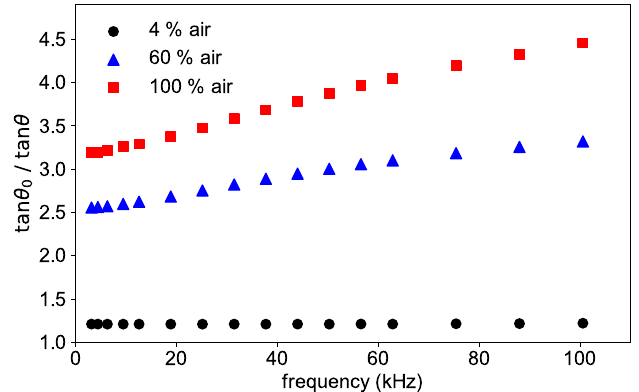
Figure 4. Phase shift measured at three different oxygen concentrations at the temperature T = 45 ◦ C as a function of the modulation